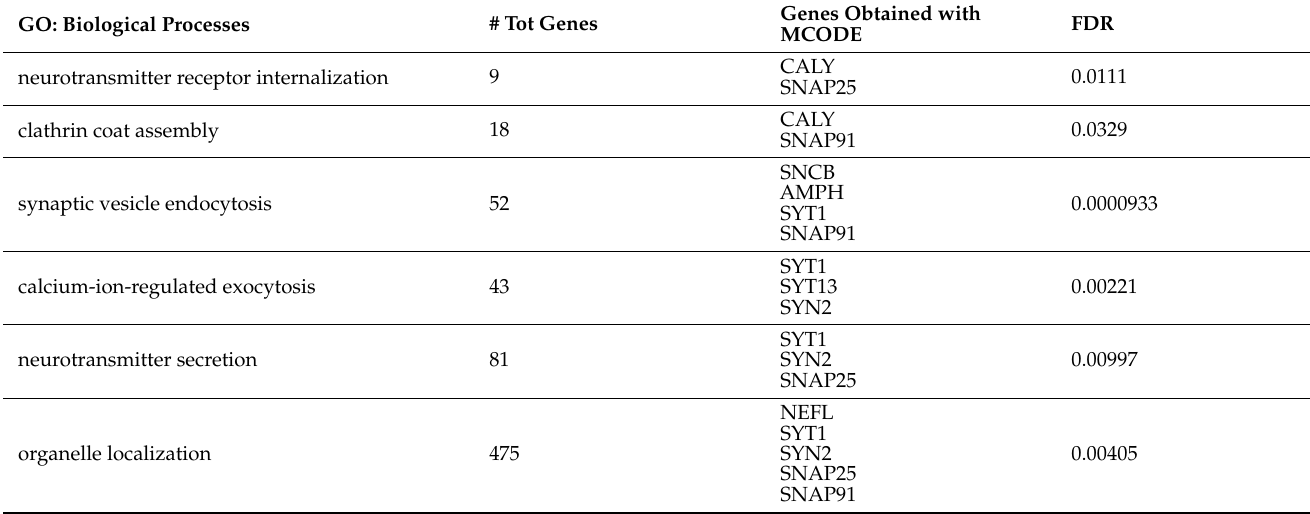
Figure 7. Interconnected regions using MCODE from the network obtained with STRING. The 12 genes obtained with MCODE were analyzed with GO to study their biological processes (Table 3). Biological processes found include neurotransmitter internalization and secretion, synapse processes, and calcium-ion-regulated exocytosis. The genes mainly involved in these processes are SNAP25, SNAP 91, SYN2, and SYT1. Table 3. Gene Ontology analysis of the 12 genes obtained with